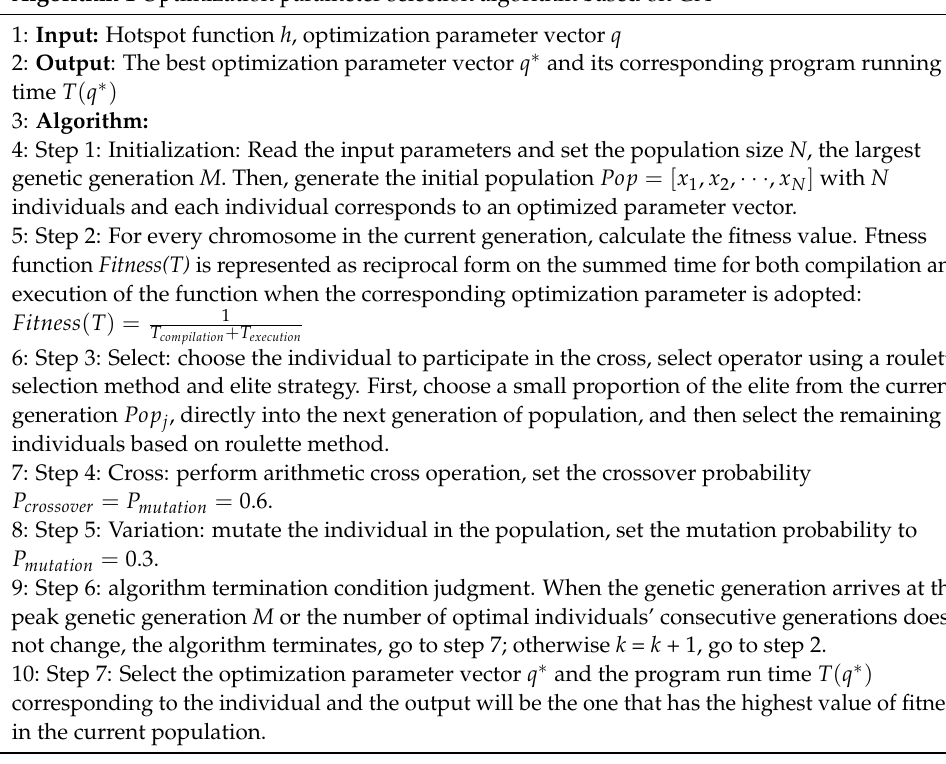
Algorithm 1 Optimization parameter selection algorithm based on